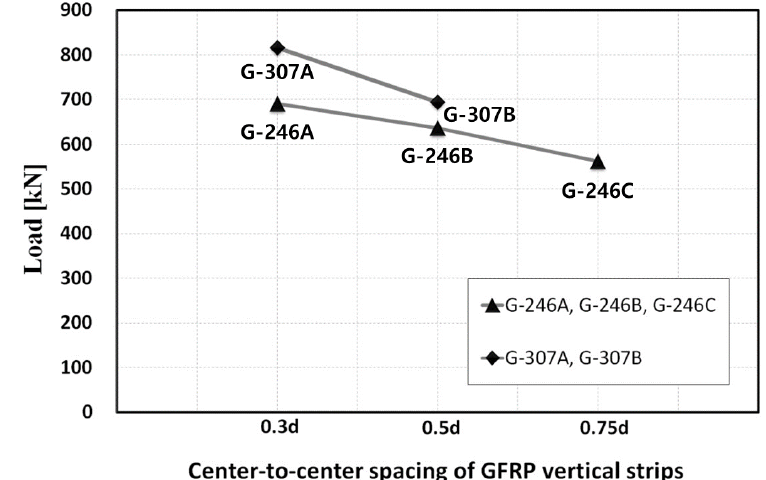
Figure 9. Shear strength for various spacings of shear reinforcement.